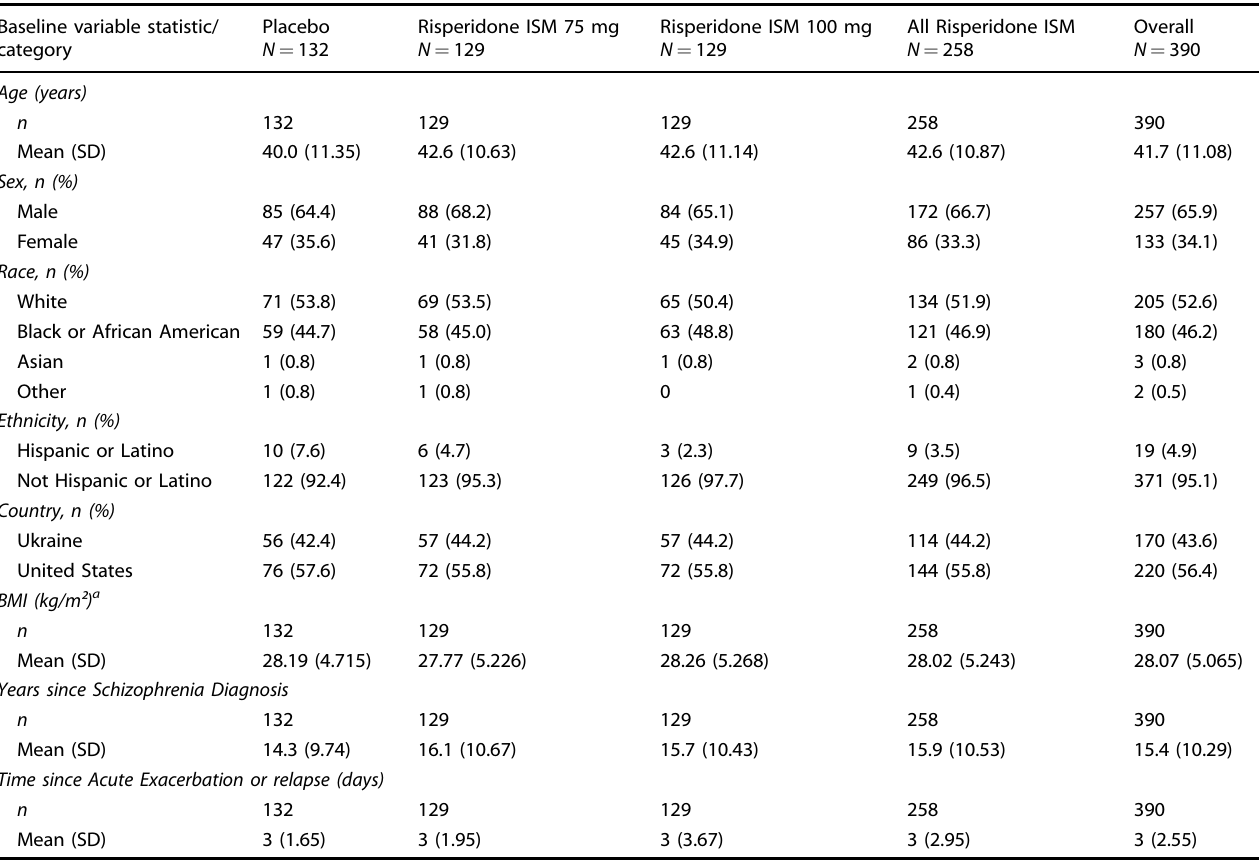
Table 1. Demographic and baseline characteristics (mITT